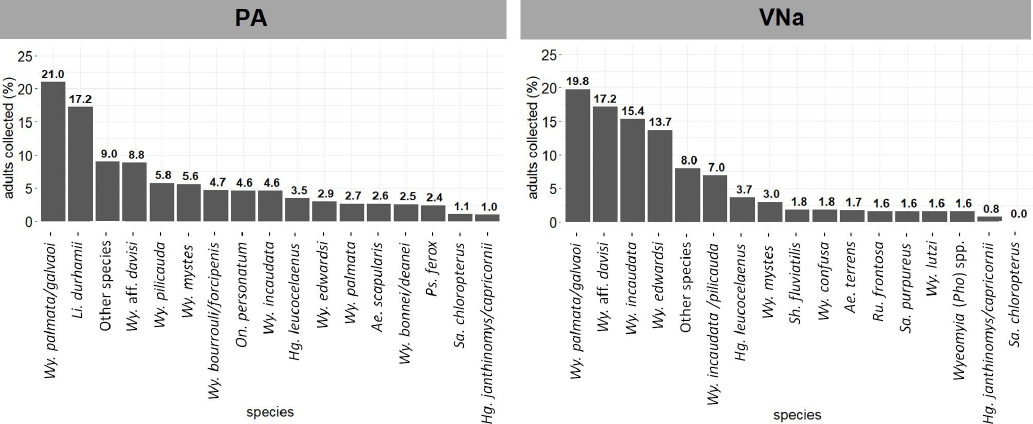
Figure 4. Most common mosquito species in adult sampling 2 in Pancas (PA) and Venda Nova do Imigrante (VNa), Espírito Santo, from March to June 2017.